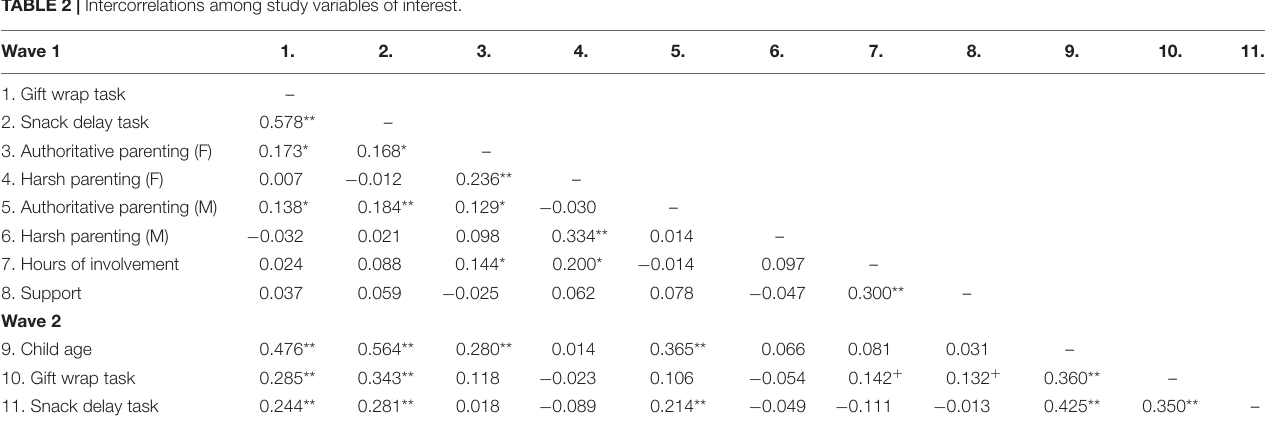
TABLE 2 | Intercorrelations among study variables of